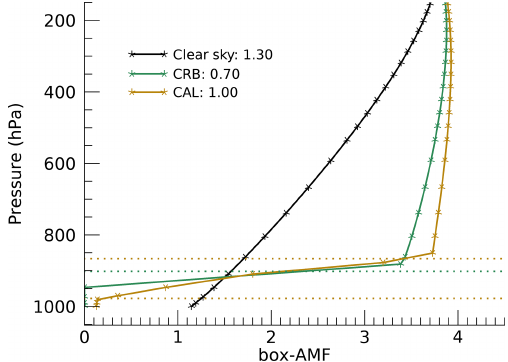
Figure 11. The box-AMFs for clear and cloudy sky using the ROCINN_CAL and ROCINN_CRB cloud models over Italy (45.3 ◦ N, 11.2 ◦ E) on 1 February 2010. The tropospheric AMF is given next to each label. The ROCINN_CRB cloud top pressure is shown as a green horizontal dotted line, and the ROCINN_CAL cloud top and base pressures are shown as brown horizontal dotted lines. The cloud radiance fraction is 0.47, the cloud optical depth is 6.85, the SZA is 69 ◦ , the VZA is 3 ◦ , and the RAA is 42 ◦ .